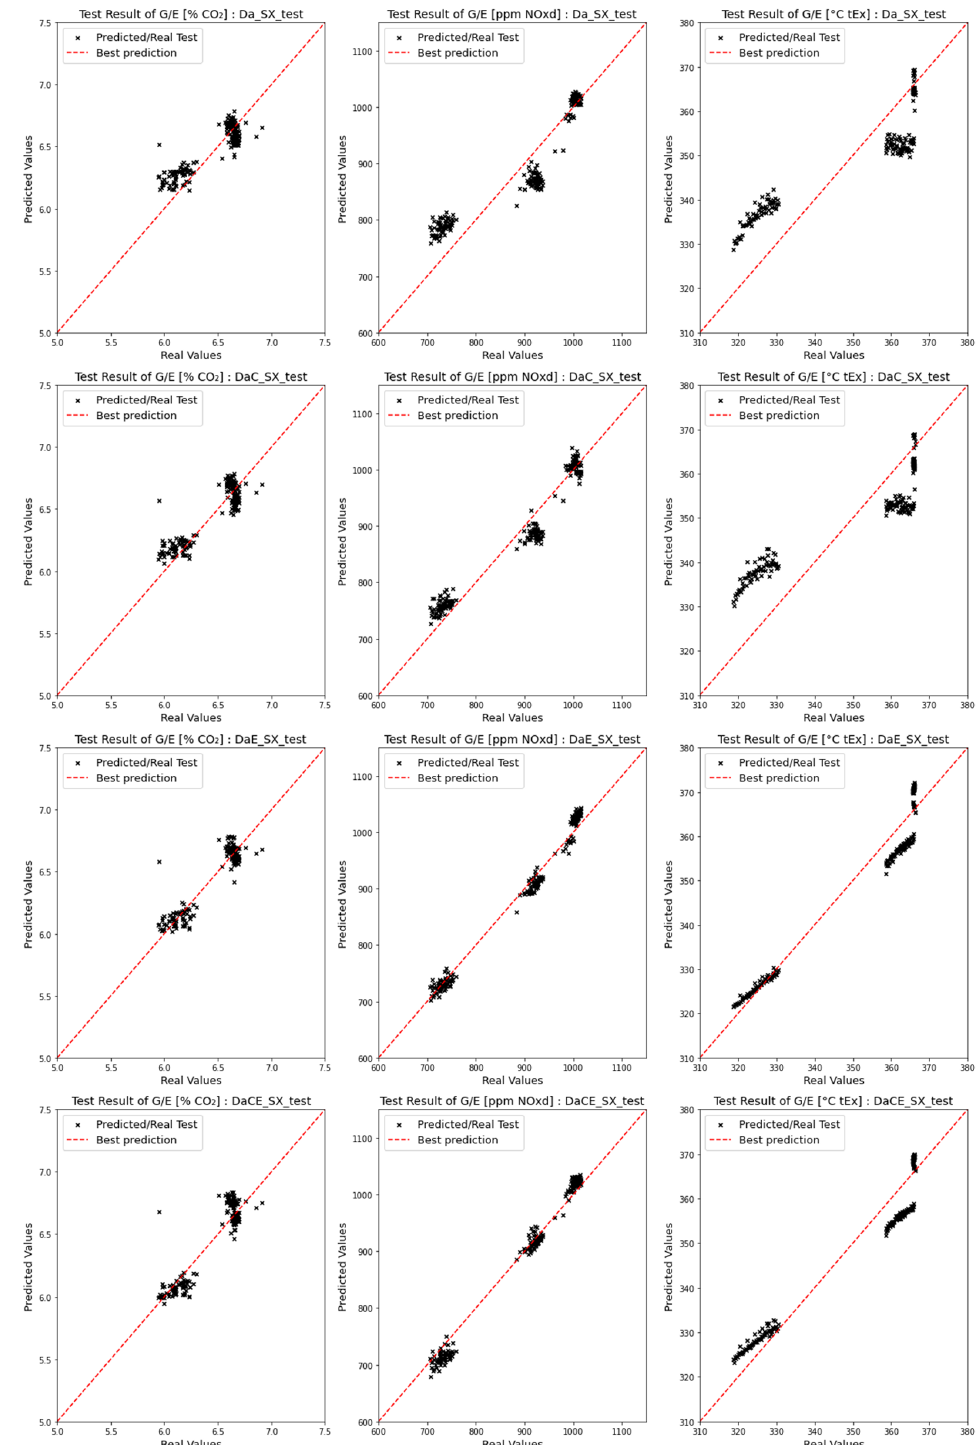
Figure 9. Comparison of dataset performances for SVM model with the no ‐ SCR mode.